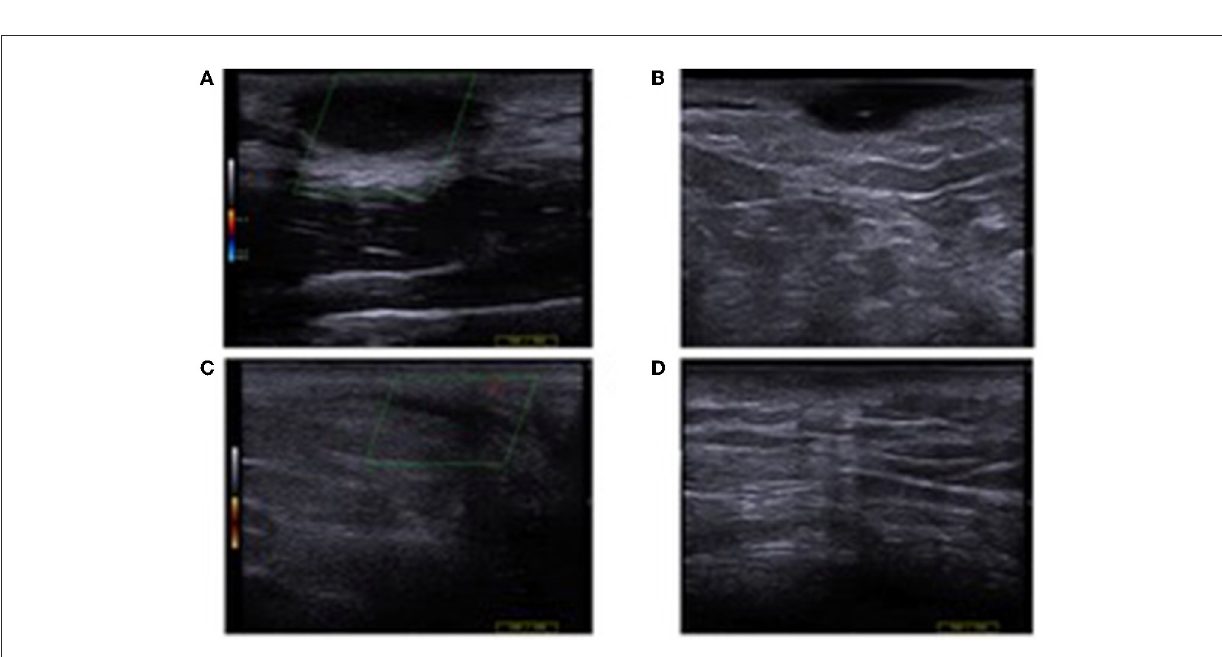
FIGURE4 Two pseudo-nodular lesions of the right armpit, before cryosurgery (A, B) and complete resolution at 6-month follow-up (C, D) .